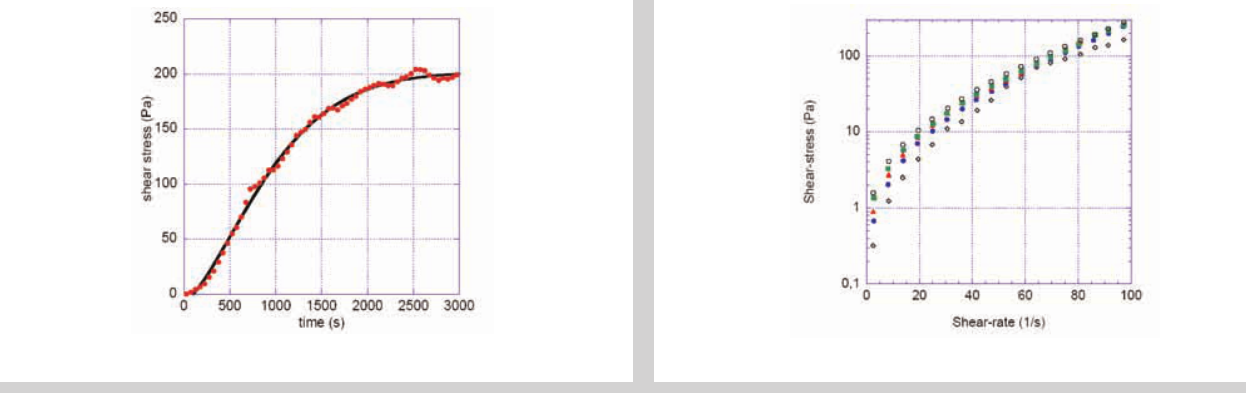
Figure 4 (left): Typical temporal evolution of the stress at a very small shear rate (0.01 s -1 )represent- ing the microstructure rebuild up after break down at a high shear rate (200 s -1 ). The continuous line corre- sponds to the best fit with a stretched exponential. Figure 5: Flow curves for different VMA dosage rates ( Ì : REF-100, Ê : REF-50, Ú : REF, ‡ : REF+50, Á :